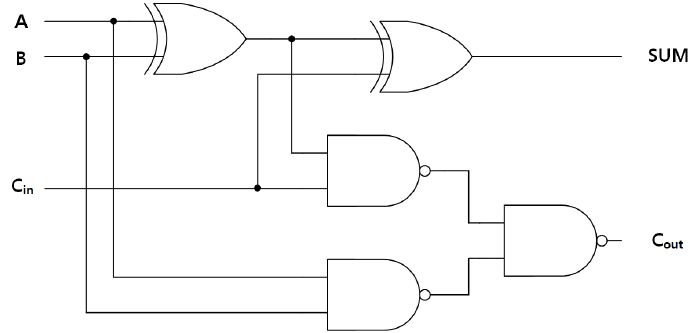
Figure 4. Conventional full adder [14].